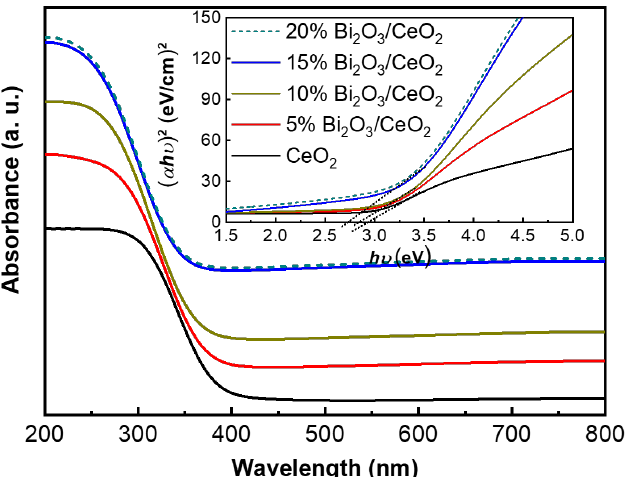
Figure 5. Light absorption spectra of the prepared CeO 2 compared with Bi 2 O 3 /CeO 2 heterojunctions and their corresponding calculated energy gaps as seen in the inset.